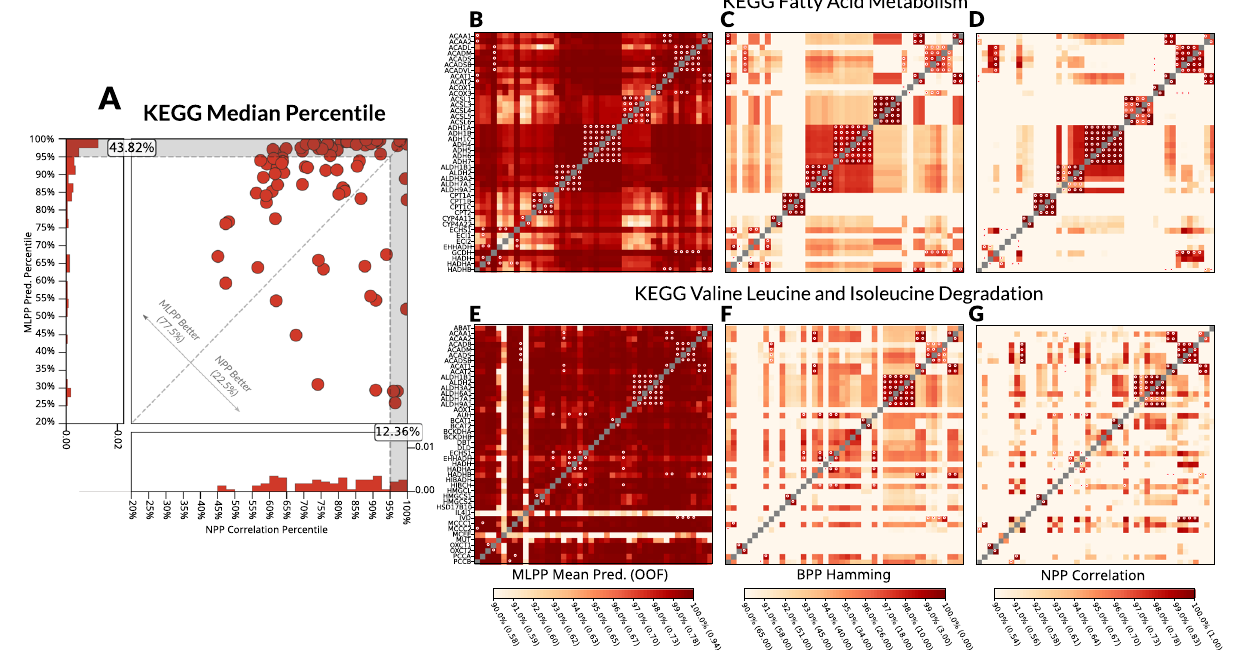
Fig. 2 Method comparison at the pathway level. The MLPP model was compared to the NPP model in terms of predicting pathways by the median percentile of the score in the pathway on the KEGG database ( A ). Speci fi c examples of fatty acid metabolism ( B – D ) and valine leucine and isoleucine degradation ( E – G ) pathways are given, comparing MLPP ( B , E ), BPP ( C , F ) and NPP ( D , G ). MLPP — machine-learning phylogenetic pro fi ling, NPP — normalized phylogenetic pro fi ling, BPP — binarized phylogenetic pro fi ling with Hamming distance. For D-I, the color represents the percentile with scores per method in brackets, while red dots are paralogous proteins. Source data are provided as a Source Data fi